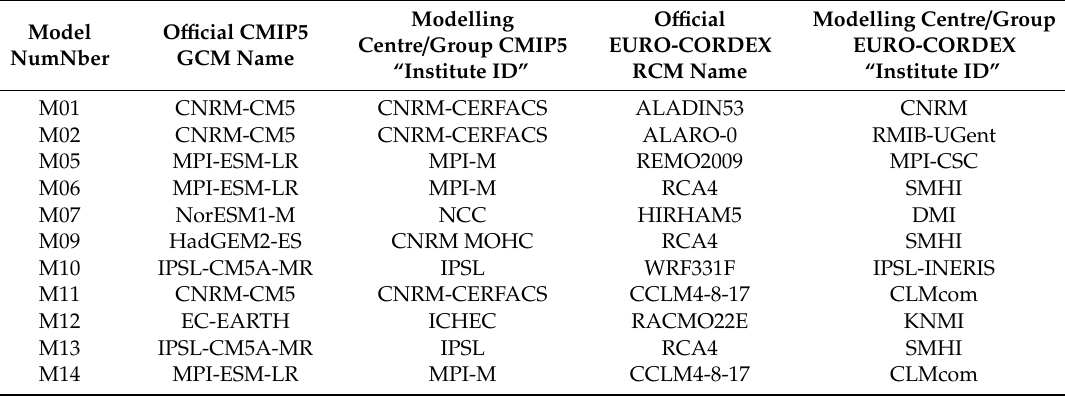
Table 1. Regional climate change projection datasets used in the study. The table contain the model abbreviations used in the text, the driving Global Climate Model (GCM), the Regional Climate Model (RCM) used for the dynamical downscaling as well as the institutions that are responsible for the model runs; temporal resolution: daily data; time span: